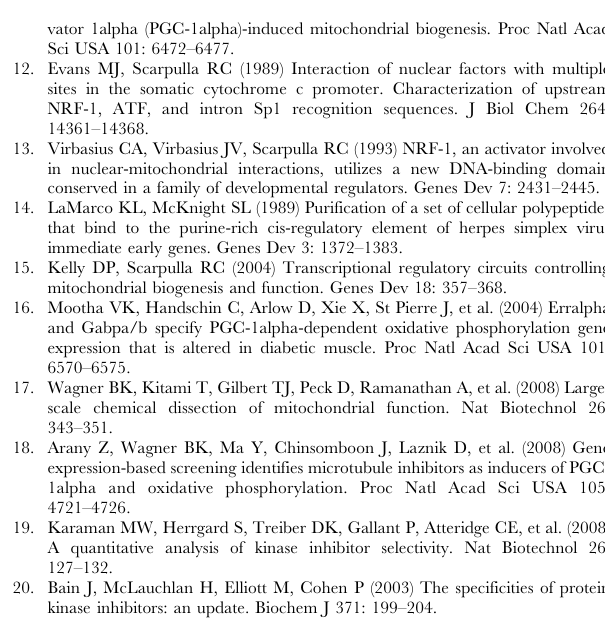
Figure S2 Impact of BRD6897 on uncoupled respira- tion. HUVEC were treated for 3-days with either DMSO negative control or BRD6897 at 5 m M, 10 m M, and 20 m M concentration. Ten biological replicates per treatment group are represented by dots. Fold change is indicated in the graph. Differences between DMSO and BRD6897 were determined by t- test. ** p , 0.01, *** p , 0.001. Figure S3 Screening structural analogs of BRD6897. 36 commercially available analogs of BRD6897 were screened using the primary assay described in Figure 1. Four analogs that showed significant MitoTracker intensity normalized to cytoplasm area were followed up with respiration measurements at 5 m M and 20 m M concentration. Activities of analogs based on uncoupled respiration are described as percent of BRD6897 uncoupled respiration. Figure S4 Time dependent effects of BRD6897 treat- ment on respiration. ( A ) Changes in basal and uncoupled respiration were measured after 0-day, 1-day, 2-day, and 3-day incubation with 10 m M BRD6897. All cells were in culture for the same 3-day duration with addition of BRD6897 at appropriate time points. Five biological replicates were tested. ( B ) Changes in basal and uncoupled respiration were measured after 0-day, 3-day, and 6-day incubation with 10 m M BRD6897. All cells were in culture for the same 6-day duration with addition of BRD6897 at appropriate time points. Media were changed at day 3. Six or eight biological replicates were tested as represented by dots. ( C ) Changes in basal and uncoupled respiration were measured after 6-day DMSO incubation (untreated), 3-day DMSO incubation followed by 3-day 10 m M BRD6897 incubation (treated), or 3-day 10 m M BRD6897 incubation followed by 3-day DMSO incuba- tion (washout). Cells were washed with media 3-times on day 3. Six or eight biological replicates were tested as represented by dots.